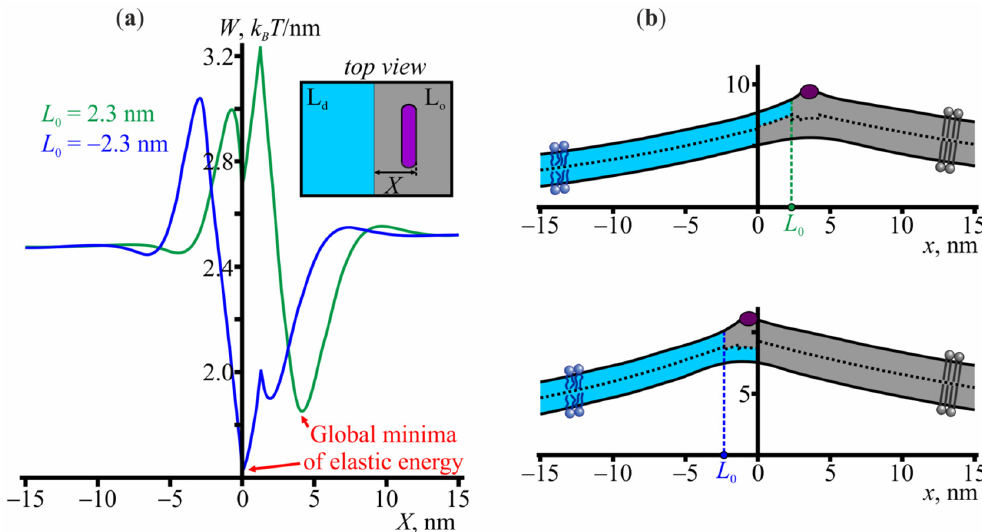
Figure 2. The interaction of amphipathic peptides with the L o domain boundary. ( a ) The elastic energy profile as a function of the coordinate X of the peptide’s right boundary. The relative shift of the boundaries of the monolayers of the L o domain is fixed at L = 2.3 nm (green curve) or L = − 2.3 nm (blue curve), i.e., at the minimum of the energy profile shown in Figure 1a. ( b ) The membrane shape in configurations corresponding to the global energy minima at the panel ( a ); top— L = 2.3 nm, bottom— L = − 2.3 nm.